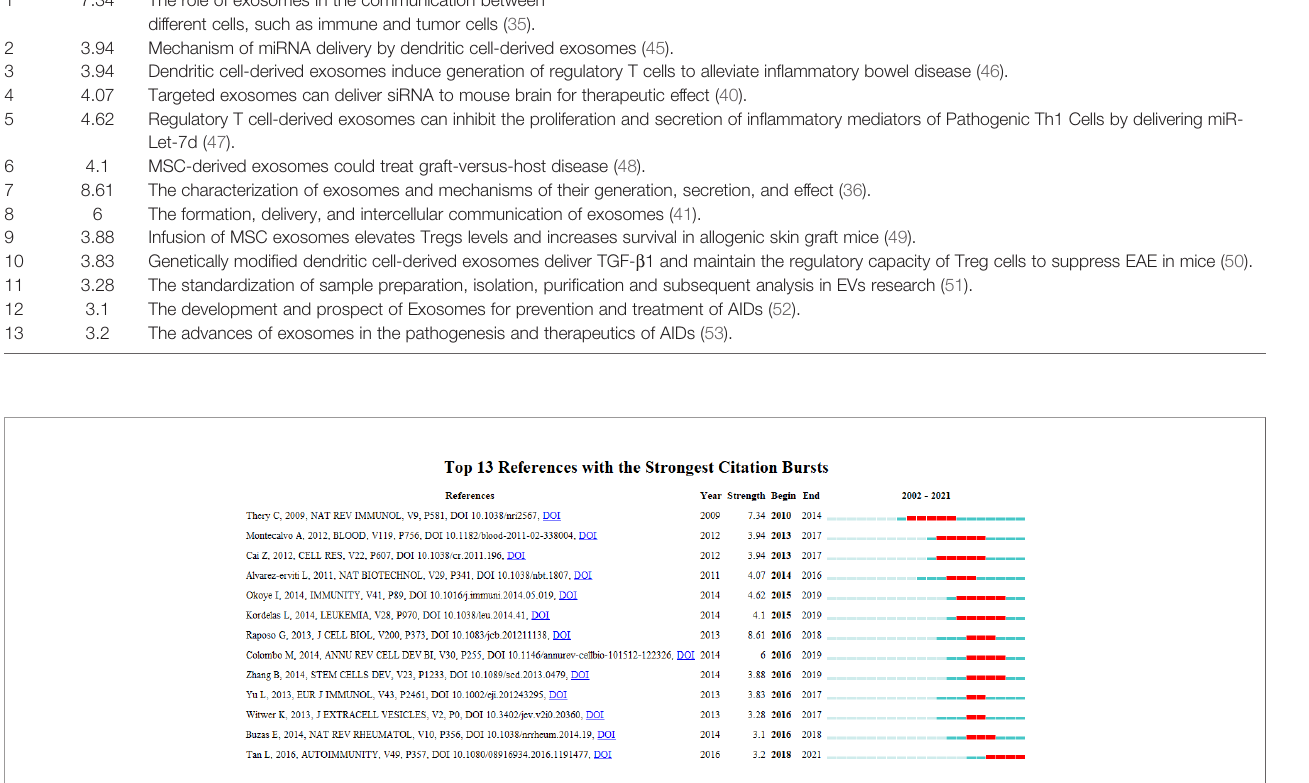
FIGURE 9 | Top 13 references with strong citation bursts. A red bar indicates high citations in that year.